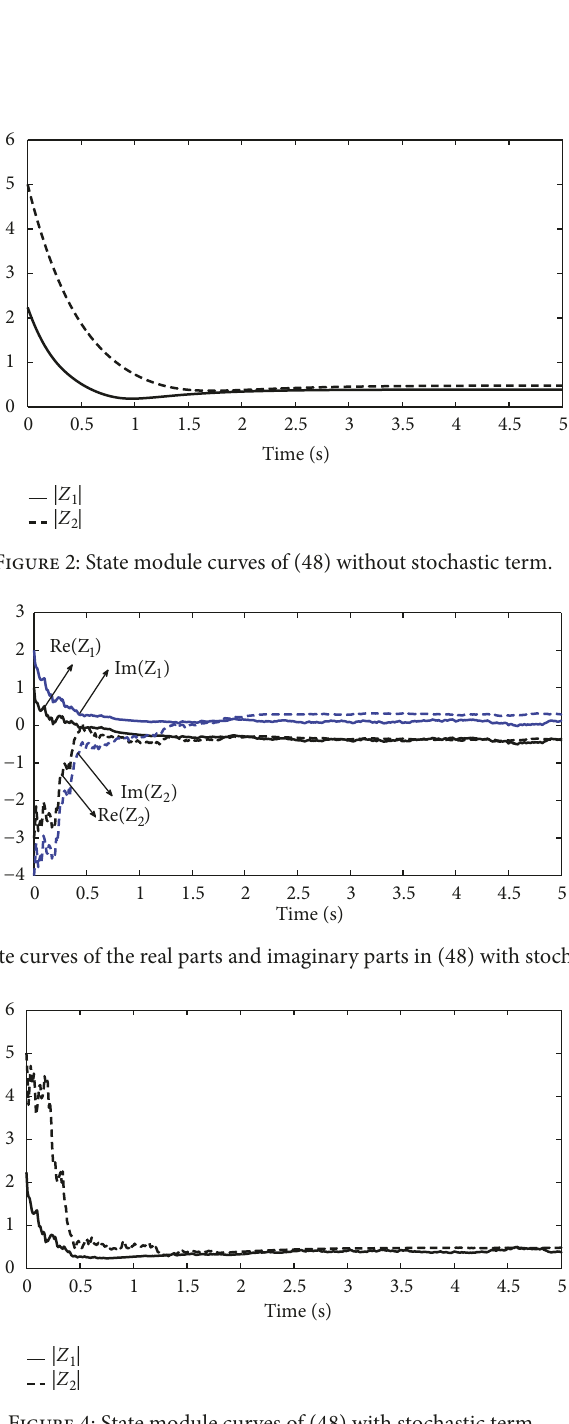
Figure 4: State module curves of (48) with stochastic term.